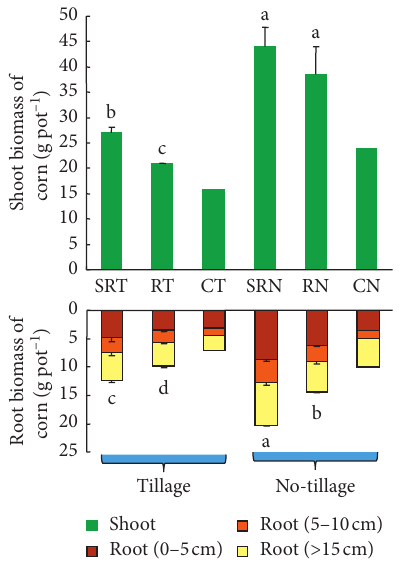
Figure 3: Shoot and root biomass of corn at 56 DAT. The different numbers show a significant difference according to the least sig- nificant difference at p < 0 . 05 ( n �